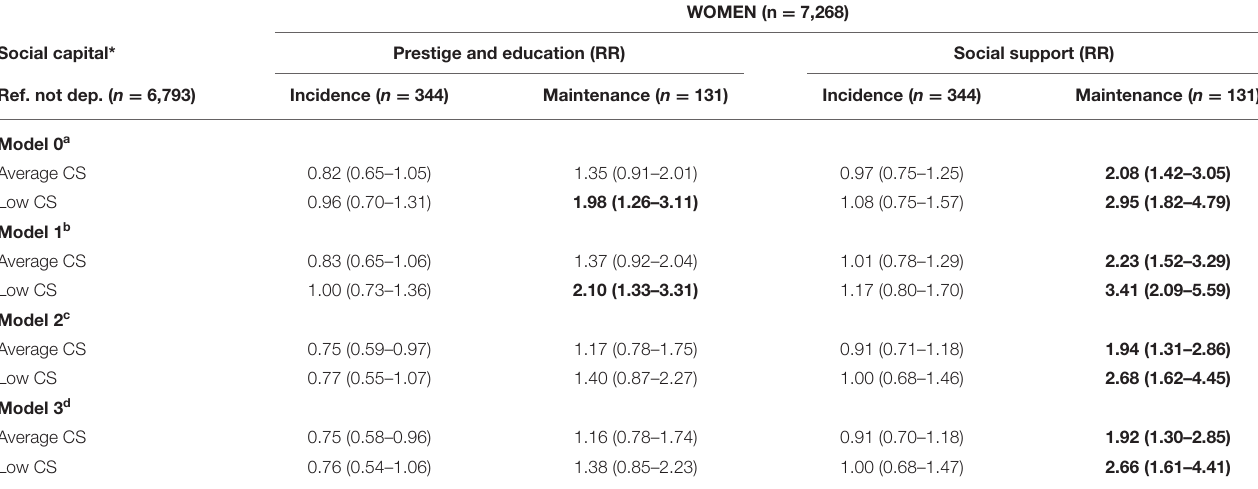
TABLE 3 | Association between social capital and the incidence and maintenance of depression among women from